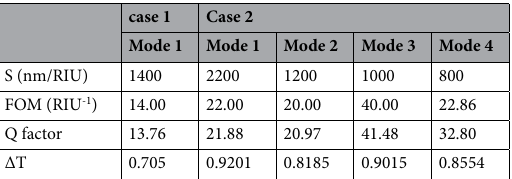
Table 1. The S, FOM, Q factor, and dip strength (ΔT) of case 1 structure for mode 1 and case 2 from modes 1 to 4.